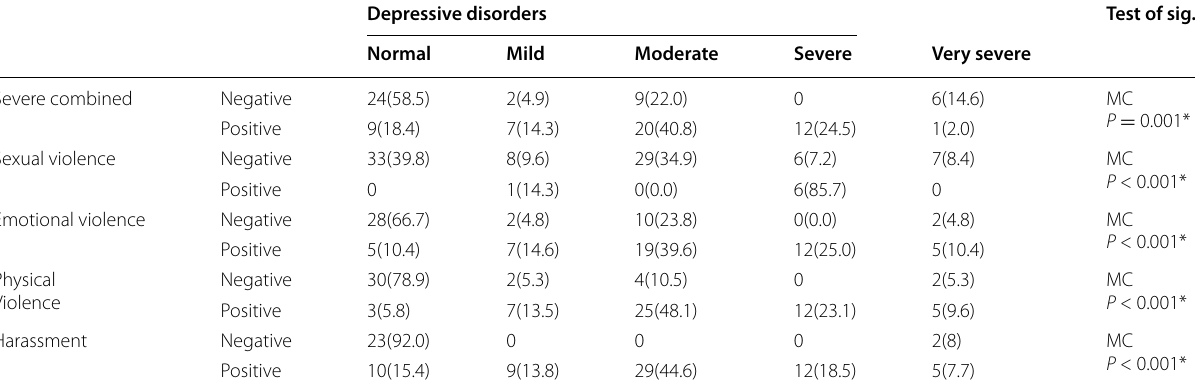
MC Monte Carlo test